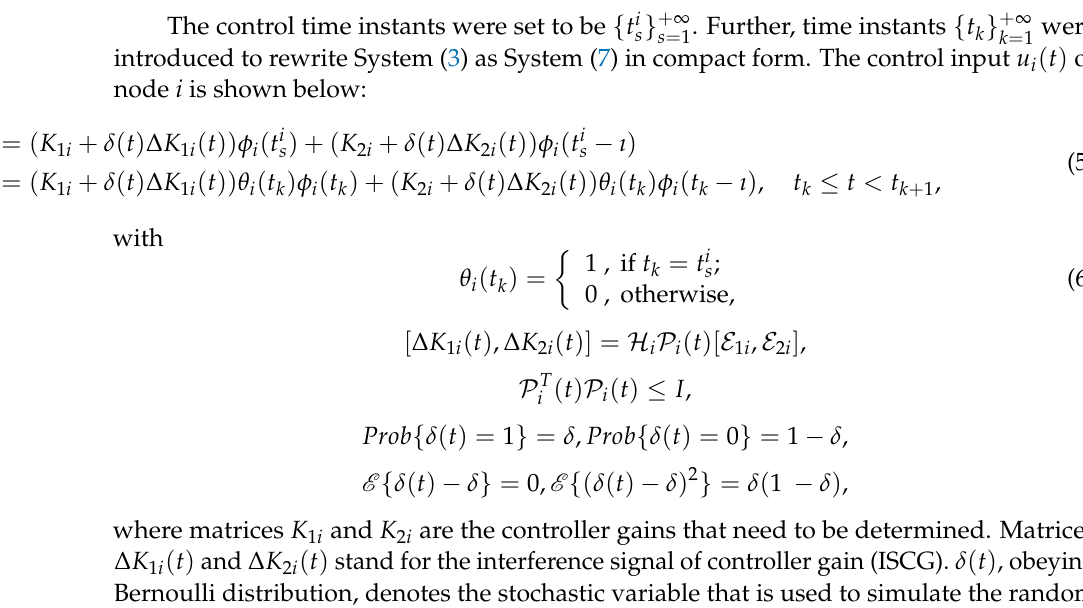
Figure 2. The triggering scheme can be in different working modes. The mode and its duration are determined with the given Markov switching